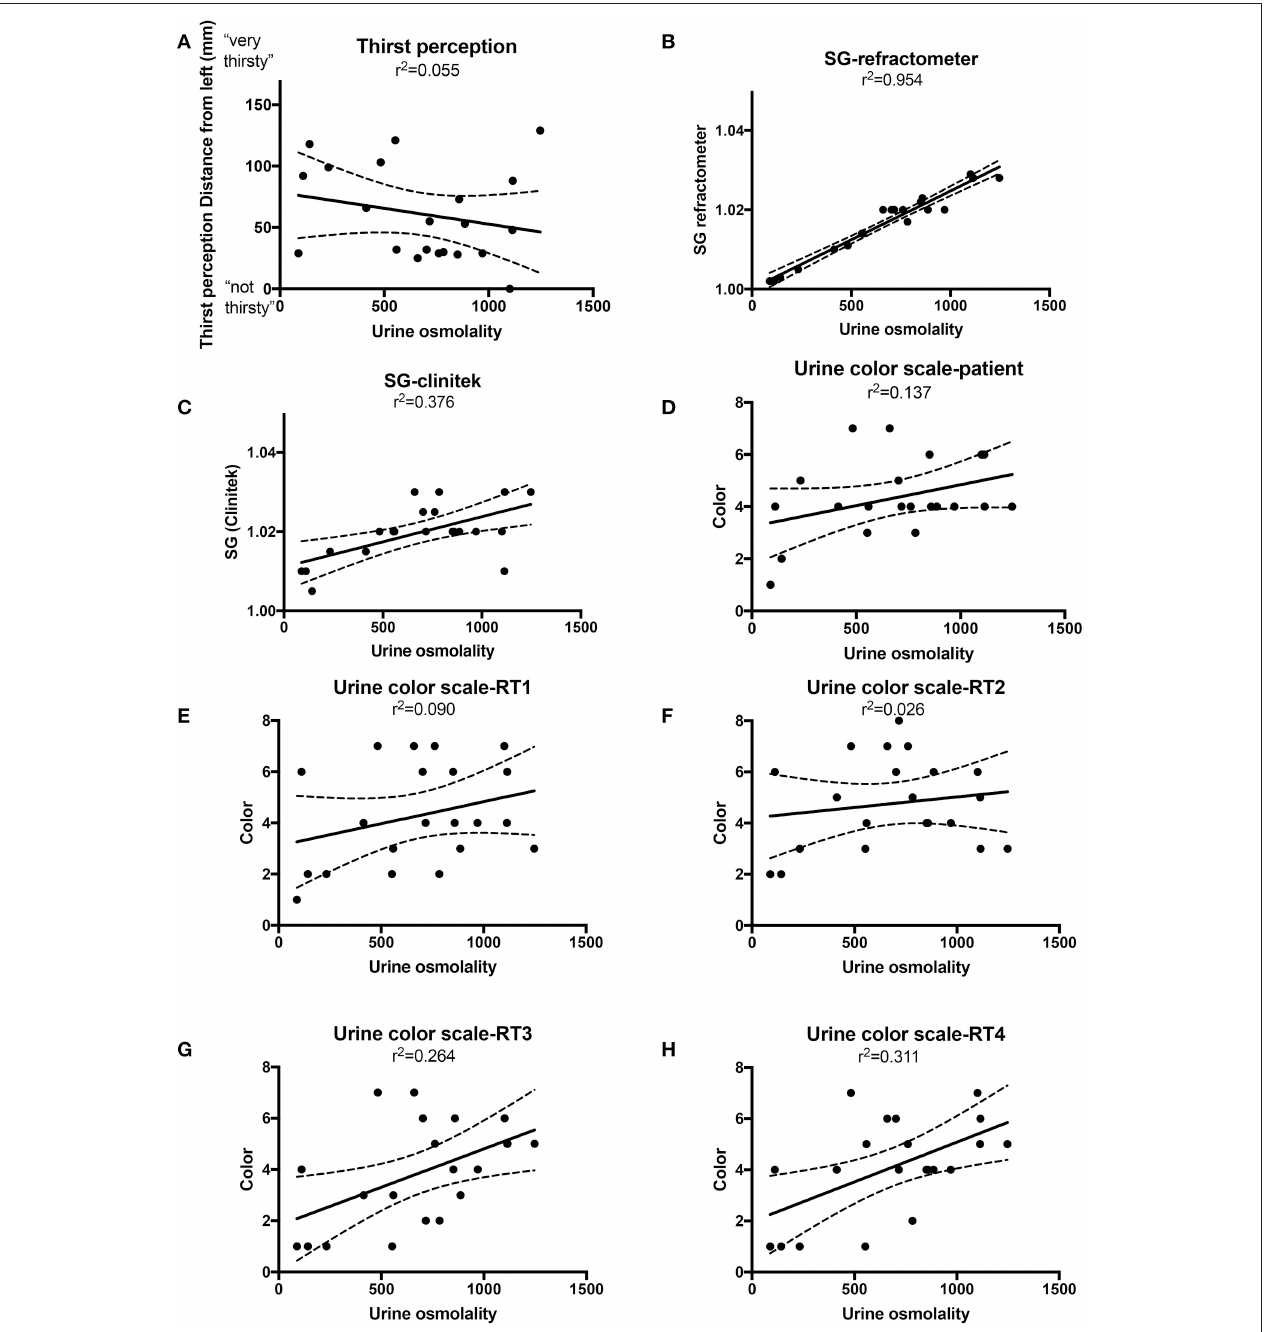
FIGURE 1 | Linear regression with best fit (solid line) and 95% confidence intervals (dashed lines) for urine osmolality vs. thirst perception (A) , specific gravity (SG) by refractometer (B) SG by Clinitek automated urine dipstick reader (C) , Urine color scale patient (D) , Urine color scale research team (RT) members 1–4 (E–H)